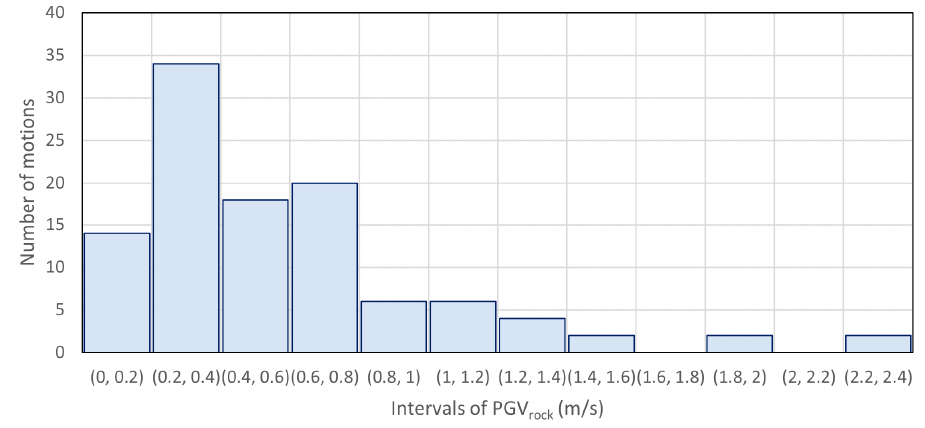
Figure 5. PGV histograms of the input motions adopted in the time ‐ history analysis.